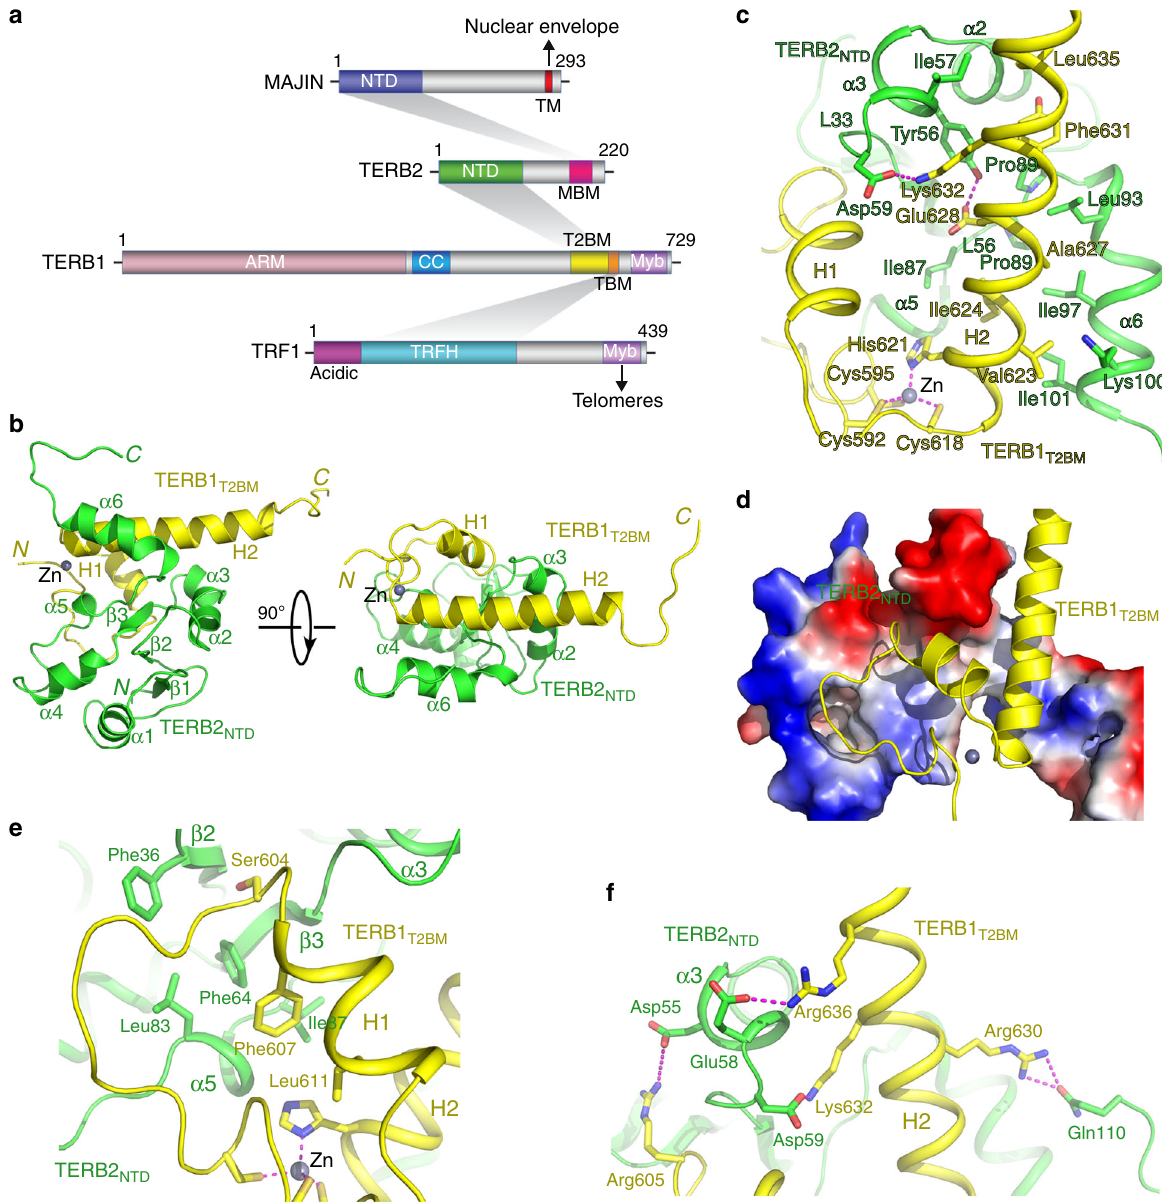
Fig. 2 Crystal structure of the TERB1 T2BM – TERB2 NTD complex. a Domain organization of TRF1, TERB1, TERB2, and MAJIN. Shadings indicate the interactions among these proteins. The interacting domains are labeled and highlighted by different colors. This diagram illustrates the TRF1 – TERB1 – TERB2 – MAJIN interaction network connecting telomeres to the nuclear envelope. Acidic acidic motif, TRFH TRF homology domain, Myb myeloblastosis domain, ARM armadillo repeats, CC coiled coil, TM trans-membrane motif. b Ribbon diagrams of two orthogonal views of the TERB1 T2BM – TERB2 NTD complex. TERB1 T2BM is colored in yellow and TERB2 NTD in green. c , e , f Detailed interactions at the TERB1 T2BM – TERB2 NTD interface. The color scheme is the same as in b . Residues important for the interaction are shown in stick models. Salt bridges and hydrogen-bonding interactions are shown as magenta dashed lines. The Zn ion is shown as a gray sphere and residues chelating this Zn ion are shown in stick model in c . d Electrostatic surface potential of TERB1 T2BM - binding site of TERB2 NTD . Positive potential, blue; negative potential,